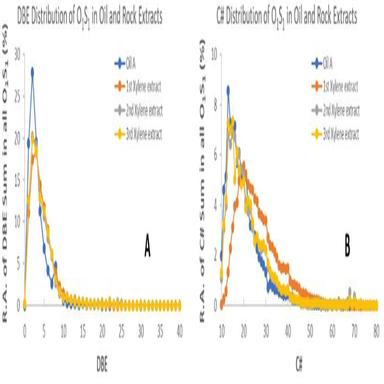
DBE distribution (A) and C# distribution (B) of the O1S1 species in Oil A and the first three xylene extracts.